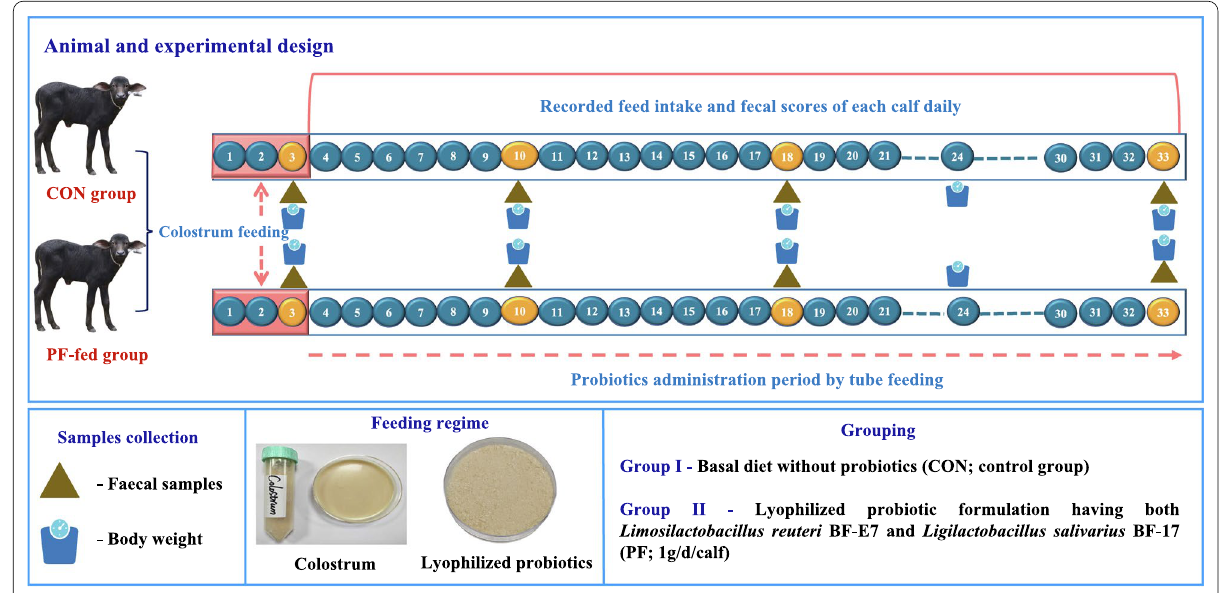
Fig. 1 Animal, experimental design, feeding regime, and sample collection of the current study in Murrah buffalo calves supplemented with probiotic product. Calves were fed colostrum up to 3 days after birth. From day 4 to 33 of age, calves were administered with probiotics by tube feeding. Body weight was recorded at day 0, 7, 14, 21, and 30 of experimental days. At day 3, 10, 18, and 33 of age, fecal samples were collected and bacterial composition of each calf was measured. From day 4 to 33 of age, fecal scores were recorded daily for each